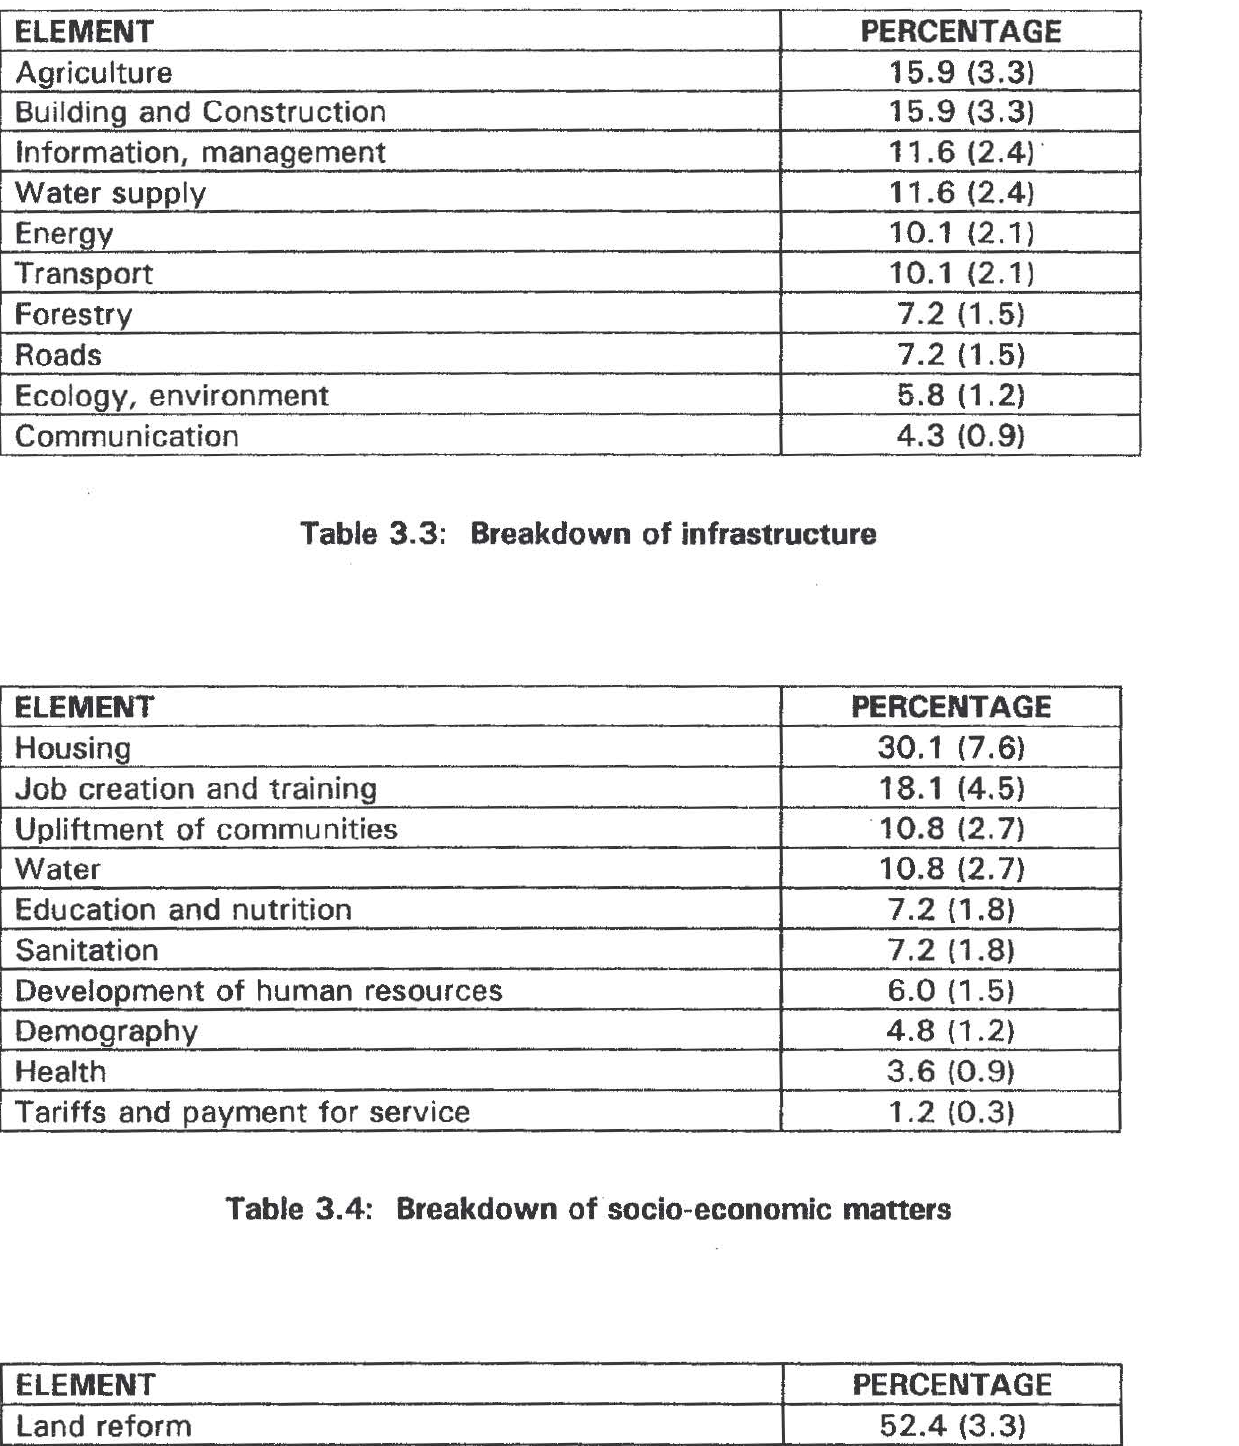
Table 3.4: Breakdown of socio~economic matters